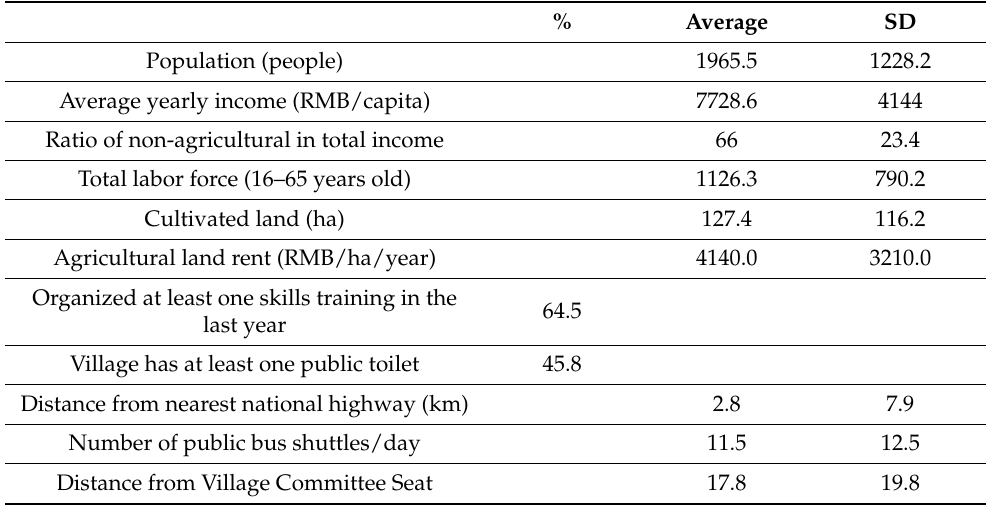
Table A2. Socio-economic background of villages in the